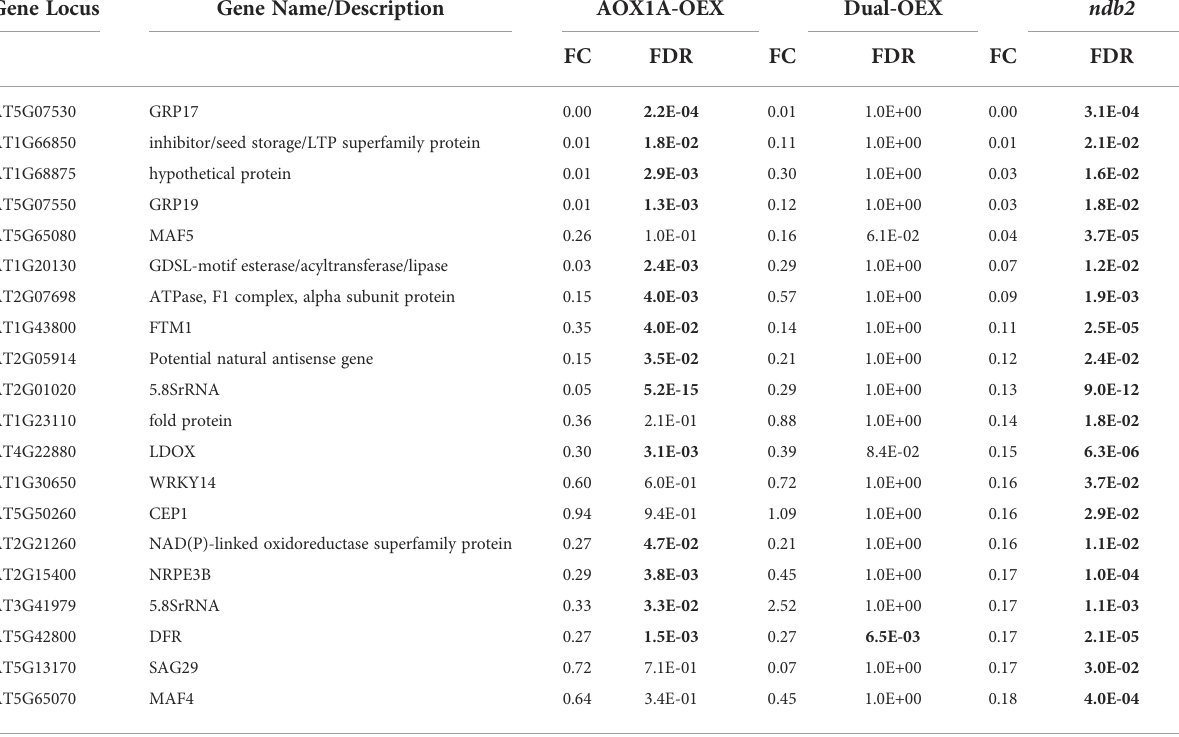
TABLE 4 Top 20 down-regulated DEGs for NDB2 knockout line relative to wild type. Gene